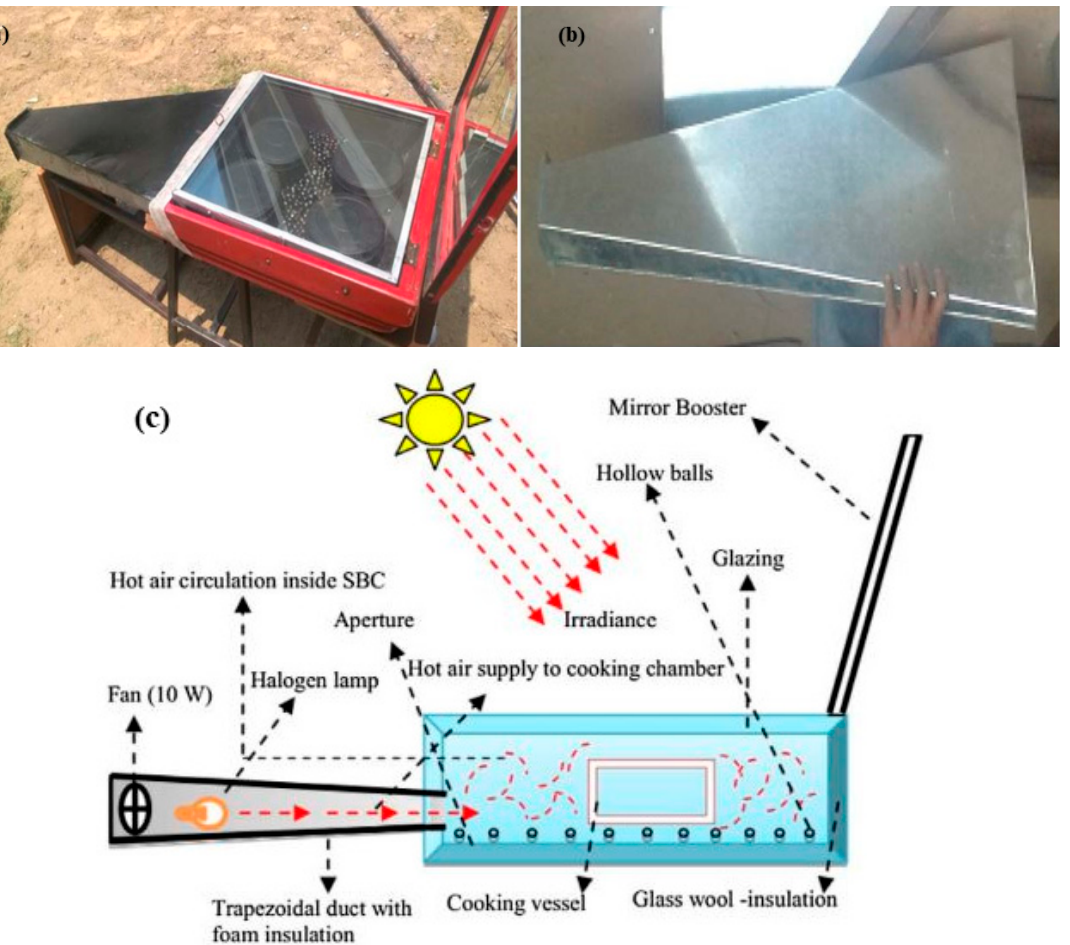
Figure 11. ( a ) Experiment set up; ( b ) Modified duct; ( c ) Schematic diagram of modified SBC. Reprinted/adapted with permission from Ref. [39], 2018, Elsevier.